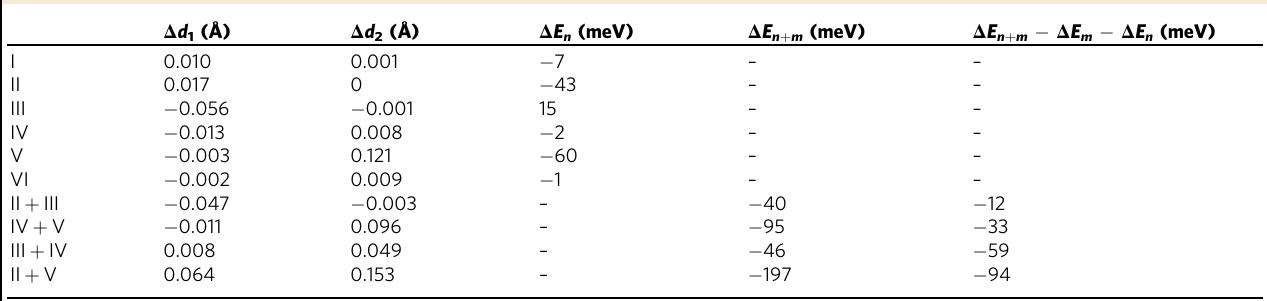
Table 1 Helicene-induced changes to the attachment of Au atom(s) to different sites of the